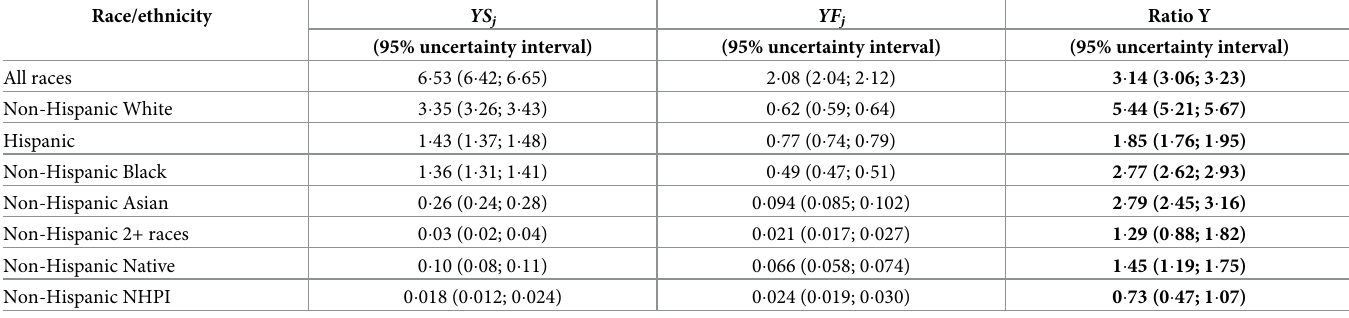
Table 4. Number of years of life saved in each race/ethnicity group by vaccinating 1,000 individuals, either allocating doses to individuals 65–74 ( YS j ) or to front- line workers ( YF j ).